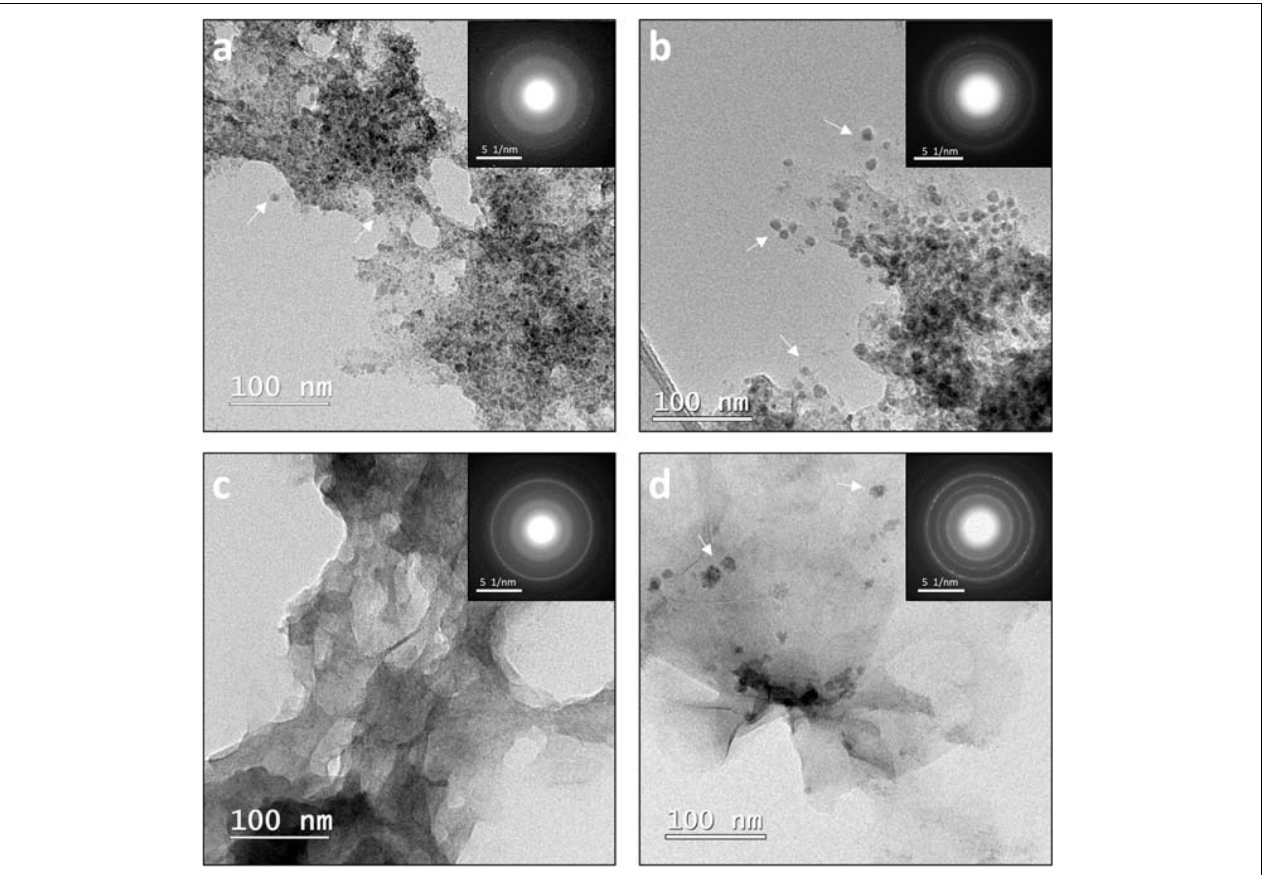
FIGURE 5 | (a,b) TEM images of abiogenic (left) and biogenic (right) precipitates from [Ni] aq /[Fe] aq = 1:1 systems. Ni-rich spheroids (examples denoted by arrows) are tightly associated with Fe-rich nanosheets. (c,d) TEM images of abiogenic (left) and biogenic (right) precipitates from [Ni] aq /[Fe] aq = 1:5 systems. The samples are dominated by Fe-rich nanosheets. Small Ni-rich spheroids (examples denoted by arrows) are also present in the biogenic precipitates but not in the abiogenic precipitates. Insets correspond to representative SADP collected from the samples. Annotated SADPs are available in Supplementary Material .